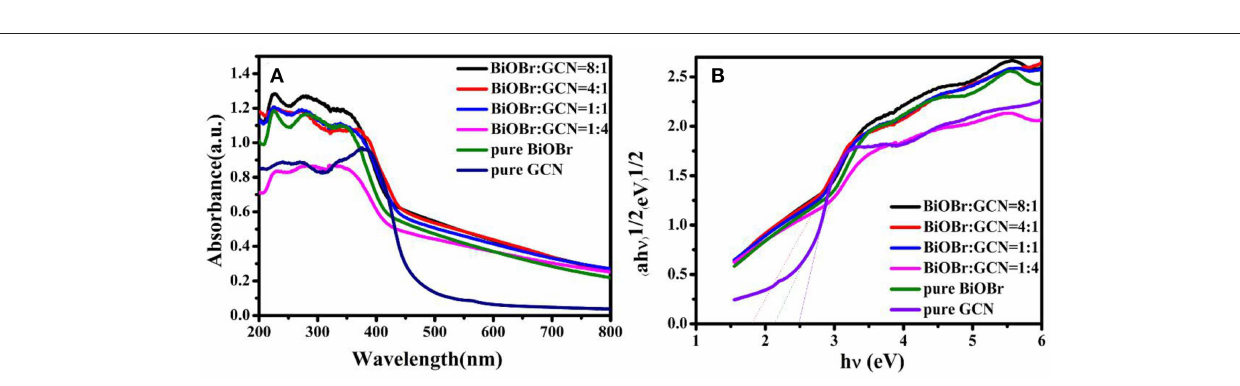
( + 1.46 eV). Meantime, the conduction band edge of BiOBr ( + 0.89 eV) is more positive than the conduction band edge of g-C 3 N 4 ( − 1.01eV). The electrons and holes were generated when electrons of valence band were excited under visible light irradiation and migrated from valence band to conduction